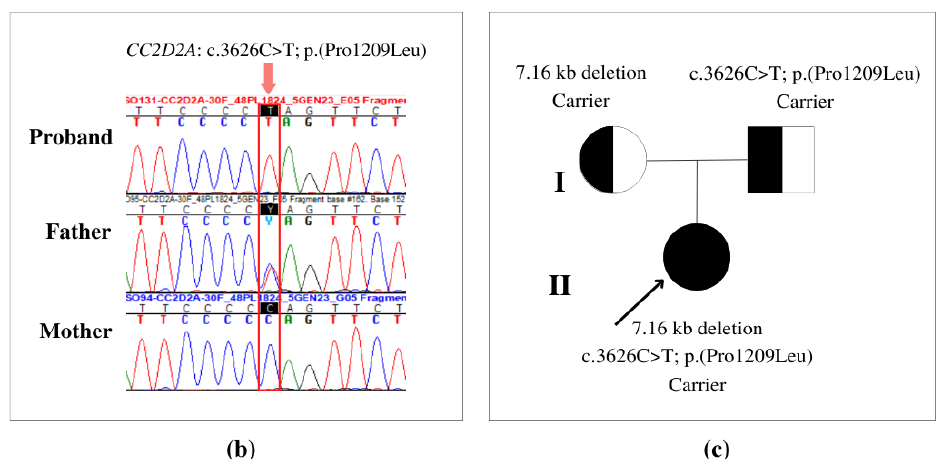
Figure 1. Clinical and genetic data. ( a ) Axial T2-weighted magnetic resonance imaging (MRI) shows thickening, elongation and horizontalization of the superior cerebellar peduncles, deep interpedun- cular fossa, and vermal hypo-dysplasia resulting in the classic “Molar Tooth Sign” (yellow arrow); ( b ) validation via Sanger sequencing that the missense variant in the patient’s DNA is in a hemizy- gous state for the variant allele (T) because of the deletion of exon 30 on the other allele. The father shows the heterozygous state with the reference allele (C) and the variant allele (T); ( c ) pedigree: in the first generation (I) half-filled diagrams are carriers and in the second generation (II) the filled-in diagram is the affected patient.